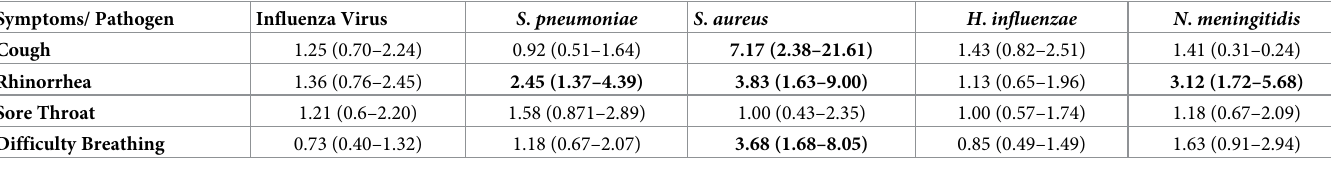
Table 4. Association of respiratory pathogens with ARI-like symptoms. OR (95%